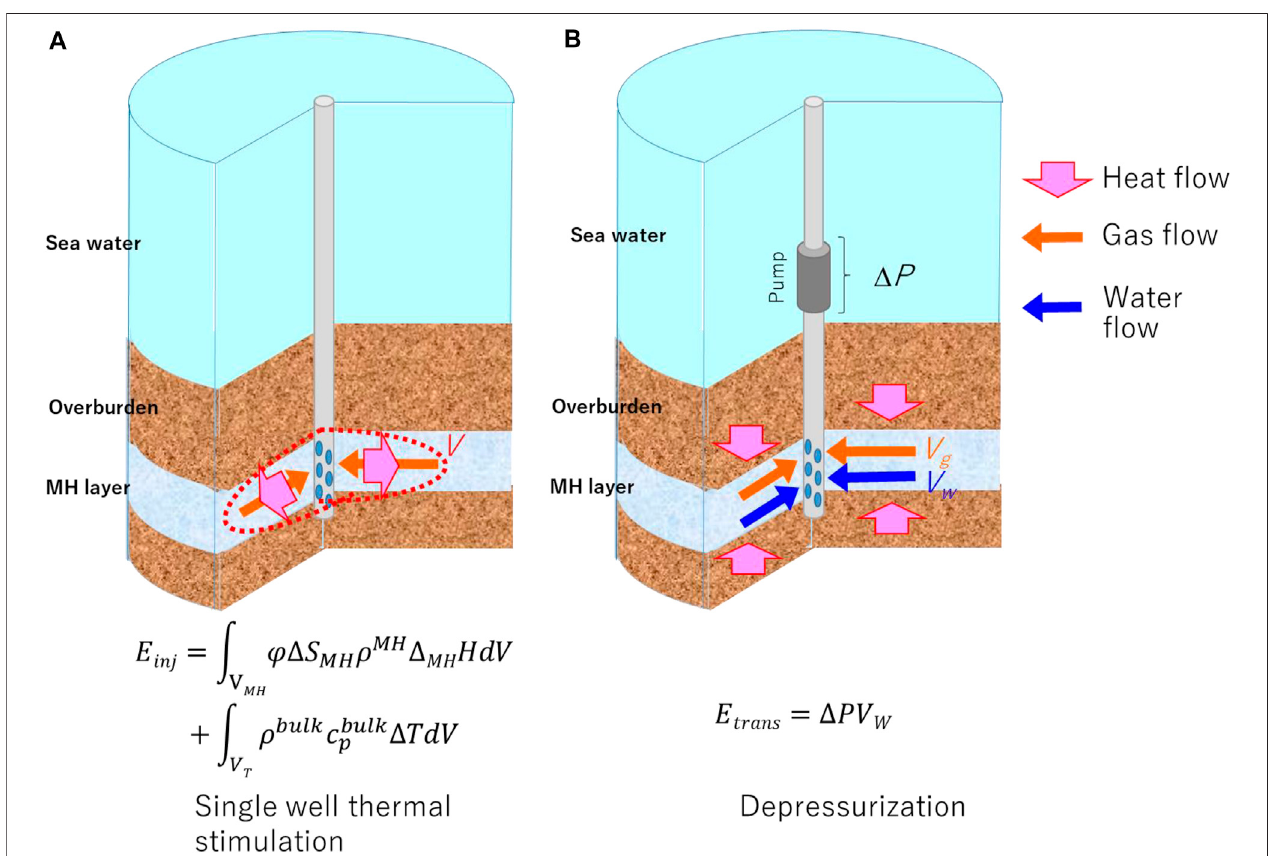
FIGURE 2 | Thermal energy injection for the “ thermal stimulation method ” ( E inj ) and work to displace water to realize the “ depressurization method ” ( E trans ). In the case of the “ depressurization method, ” the necessary thermal energy is supplied from the explicit heat of the initial and phase equilibrium temperature, as shown in Figure 1 .